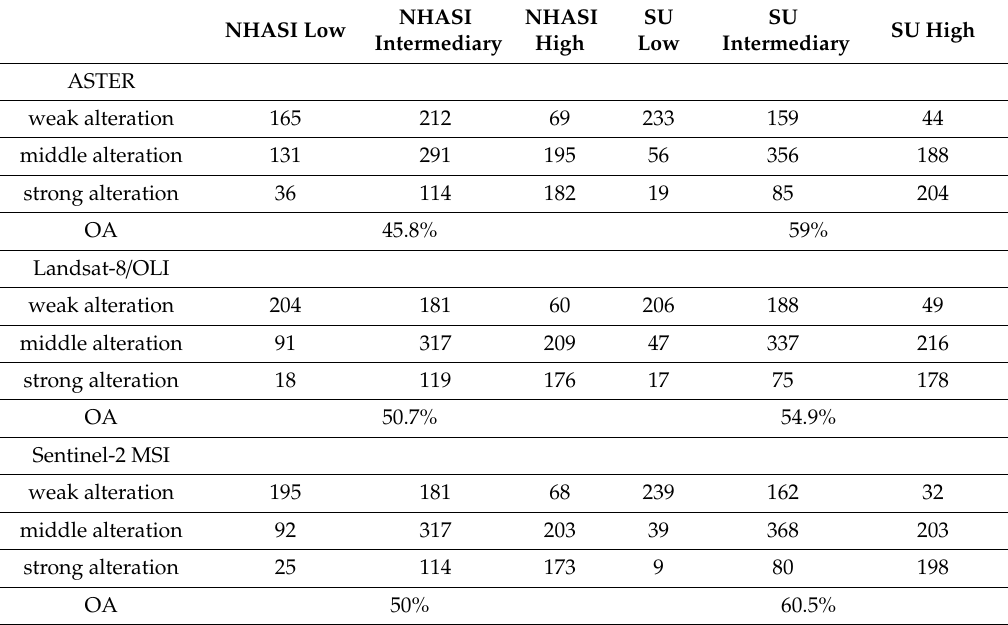
Table 3. Confusion matrices between the three alteration degree classes of the reference map (source [68]) (in lines) and the three categories of the quantized NHASI values and hydroxyl-bearing alteration abundances (issued from SU) (in columns). The overall accuracy is also shown in percentage. OA: overall accuracy. NHASI NHASI SU SU SU High NHASI Low Intermediary High Low Intermediary 165